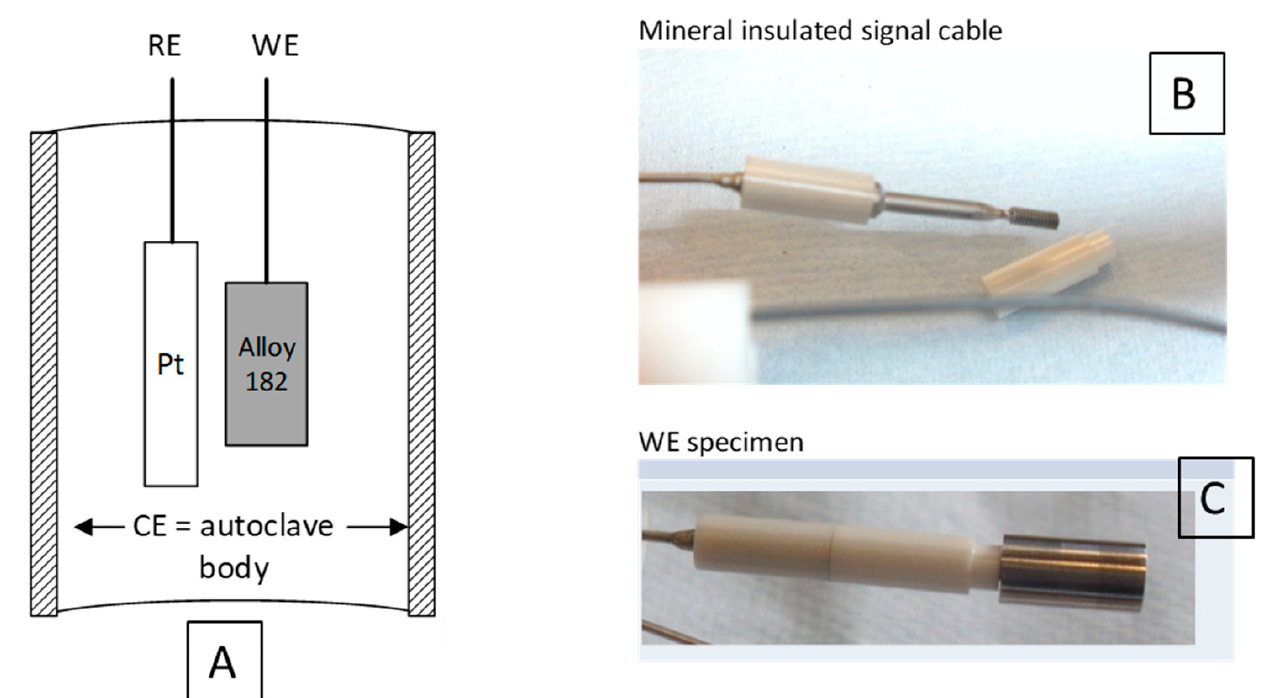
Figure 3. ( A ) Electrode arrangement in the autoclave Pt reference electrode (RE), Alloy 182 working electrode (WE) and autoclave body as counter electrode (CE), ( B ) mineral insulated signal cable with special ceramic connector, ( C ) Alloy 182 specimen connected to the cable and ceramic connector.